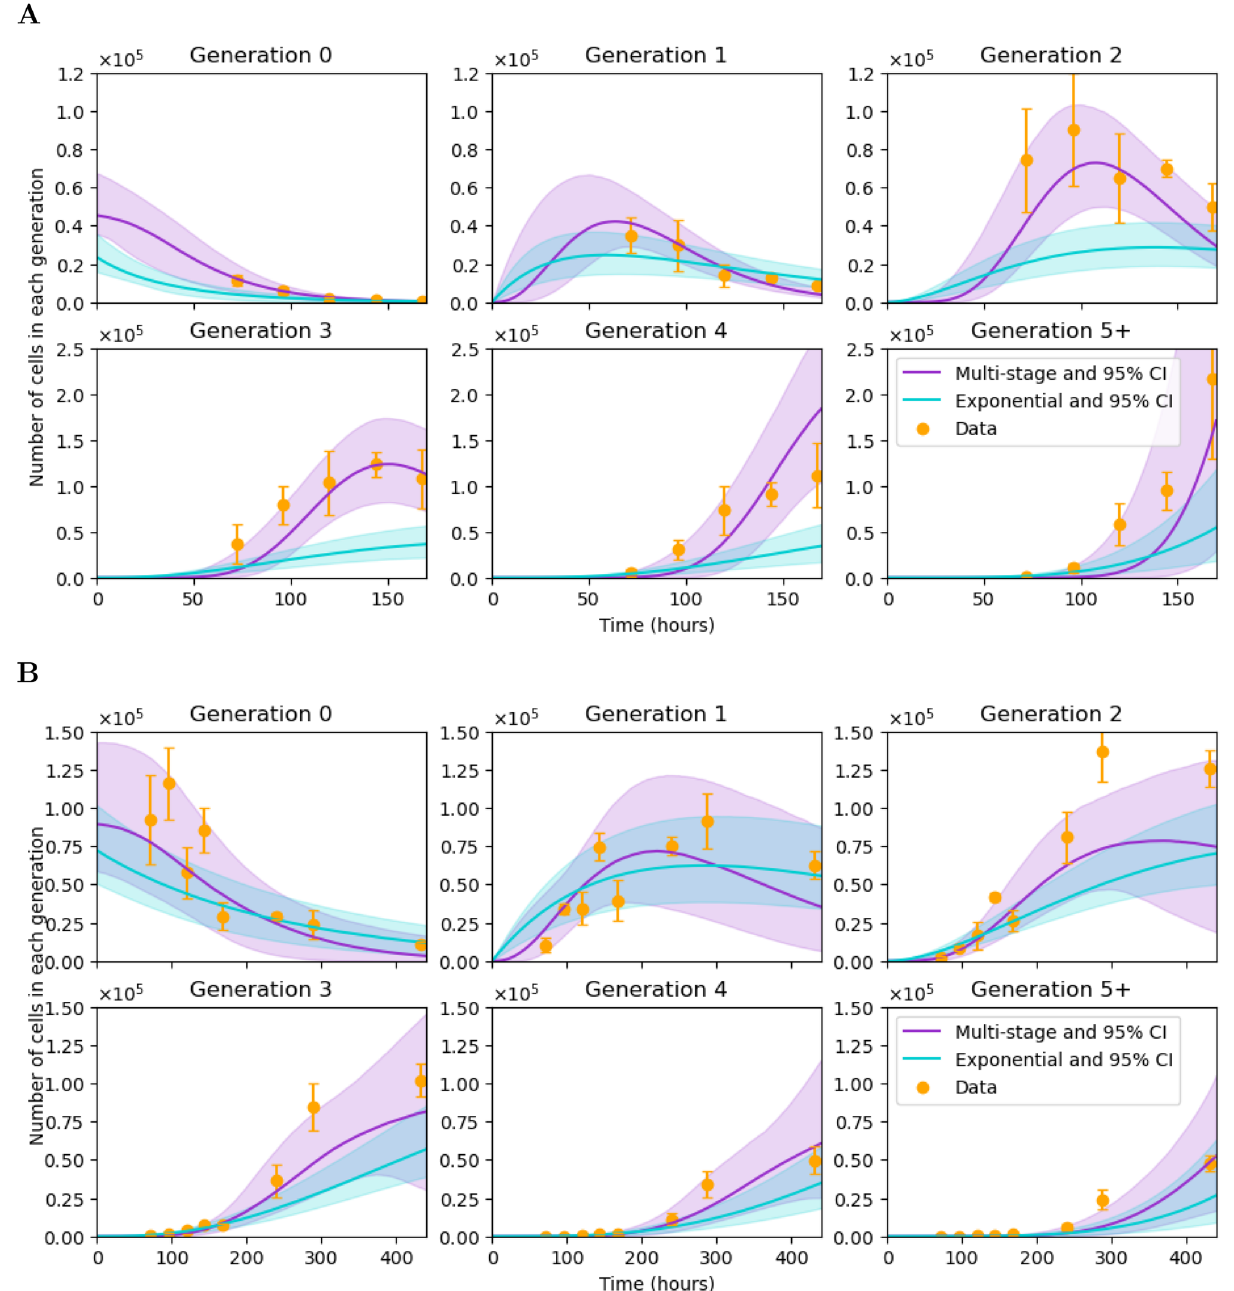
Figure 7. Exponential (solid turquoise line) and multi-stage (solid magenta line) model predictions compared to the data sets (orange dots) for OT-I ( A ) and F5 ( B ) T cells. Bars on data points represent their standard deviation. The expected number of cells in each generation is plotted as a function of time. These predictions represent the median value of 10 4 simulations with the accepted parameter values from the posterior distributions. Shaded areas represent 95 % confidence